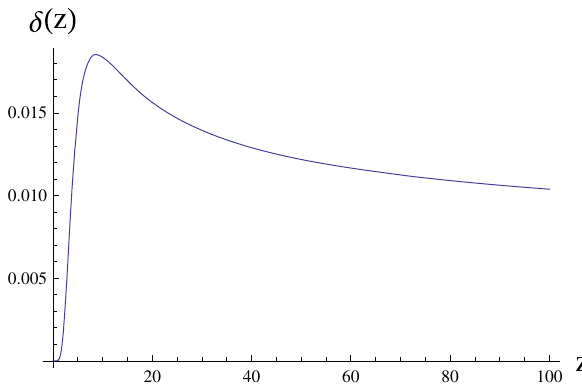
Fig. 4 A diagram of the evolution of δ( z ) , where z is redshift. For illustrationweput β = 800, Γ 0 = 20 ¯ h and (cid:16) = 1000 ρ bare .Thefunction δ( z ) reaches the maximum for z = z 0 , which is a solution of equation δ( z ) = Q ( z 0 ) 0 H ( z 0 )ρ DM ( z 0 )